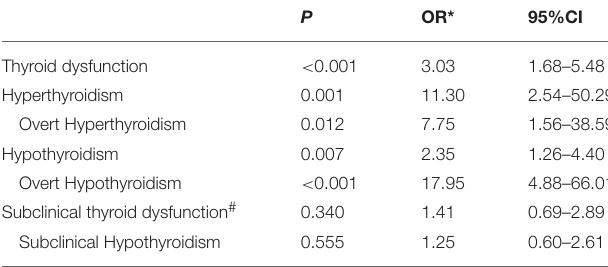
TABLE 3 | Outcomes in the relationship between RA and thyroid dysfunction from the logistic regression analysis.